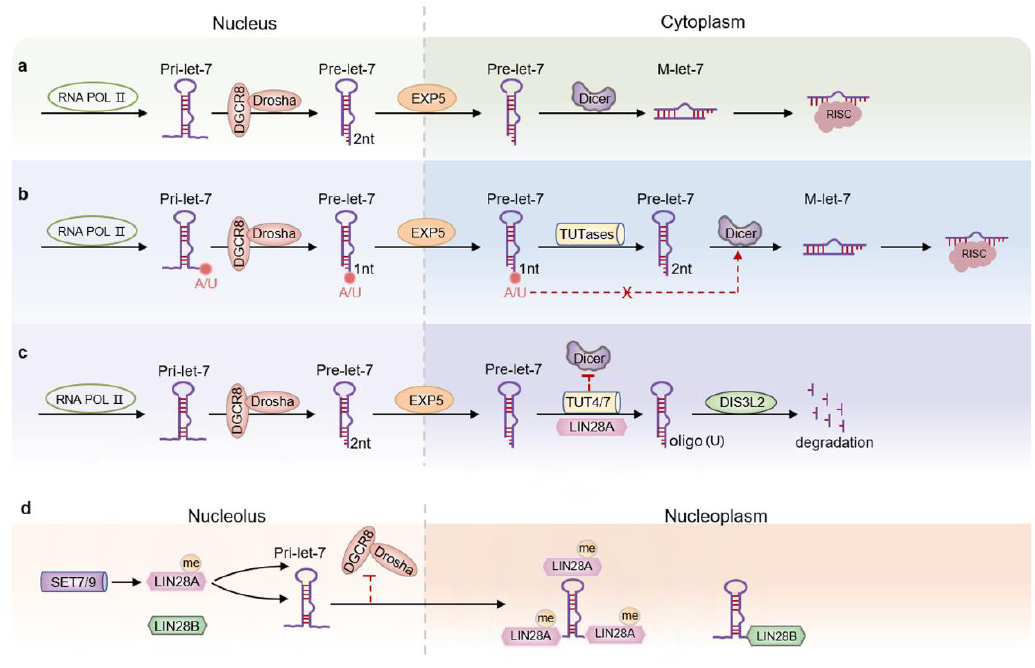
Figure 2. Biogenesis and regulatory pathways of let-7 family members. ( a ) Let-7 follows the typical miRNA biogenesis pathway. ( b ) TUTases specifically mono-uridylate the 3′ end of the 1 nt, yielding the 2 nt 3′ overhang preferred by Dicer to facilitate processing of pre-let-7. ( c ) Pre-let-7 is oligonu- cleotidylated at the 3′ end by Lin28A and TUT4/7 and is resistant to cleavage by Dicer but sensitive to catalytic degradation by DIS3L2. ( d ) The methylated Lin28A and Lin28B nucleus bind to pri-let- 7 in the nucleus and segregate it into nucleosomes, preventing Drosha-mediated processing.